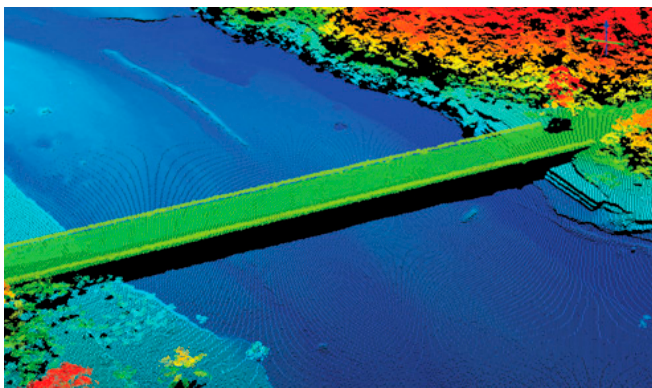
Figure 10. Lidar image of a bridge in Port-au-Prince, Haiti.